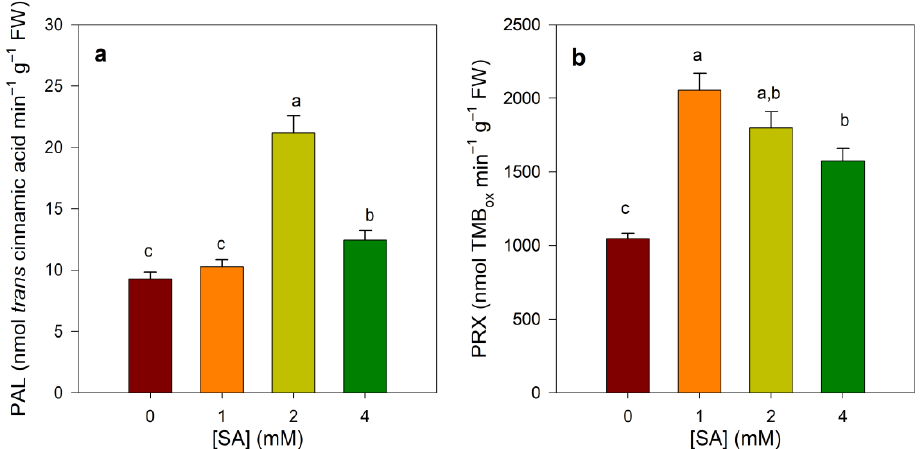
Figure 4. Effect of foliar SA applications on PAL ( a ) and Prx ( b ) activities in leaves of 45-day-old okra plants. The data are means ± SE from n = 16 from two experiments. Different letters indicate significant difference at p < 0.05 (Tukey’s HSD post hoc test). F -values and level of significance from ANOVA: PAL, 501.27 ***; and Prx, 22.30 *** (*** p ≤ 0.001).